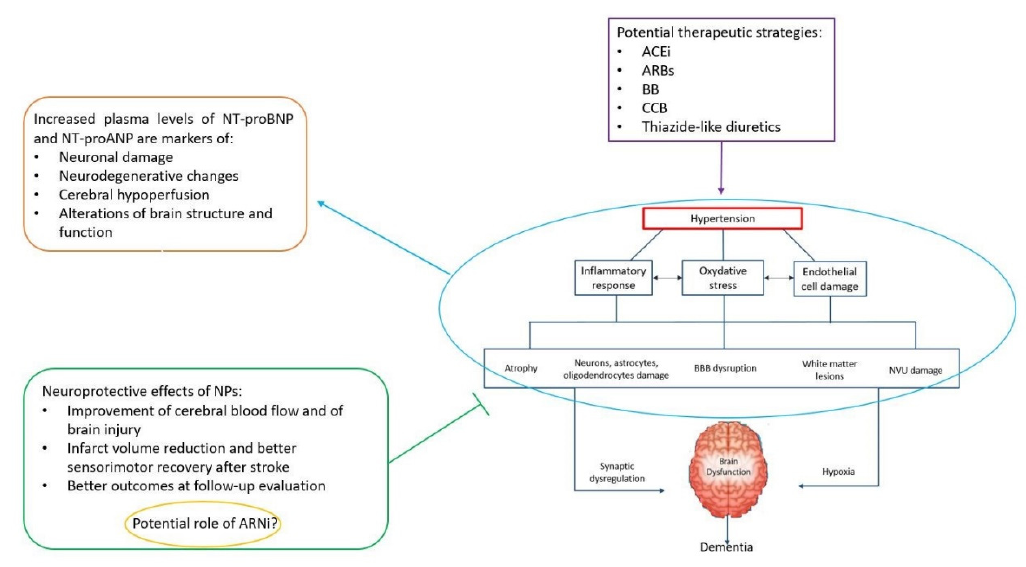
Figure 1. Schematic representation of the pathophysiological mechanisms underlying the development of dementia in hypertension: The role of aminoterminal natriuretic peptides (NT-proNPs) as both markers of brain damage and neuroprotective agents is highlighted. An appropriate antihypertensive treatment can be started on time by taking advantage of the NT-proNP levels in order to counteract the evolution to dementia in older patients.